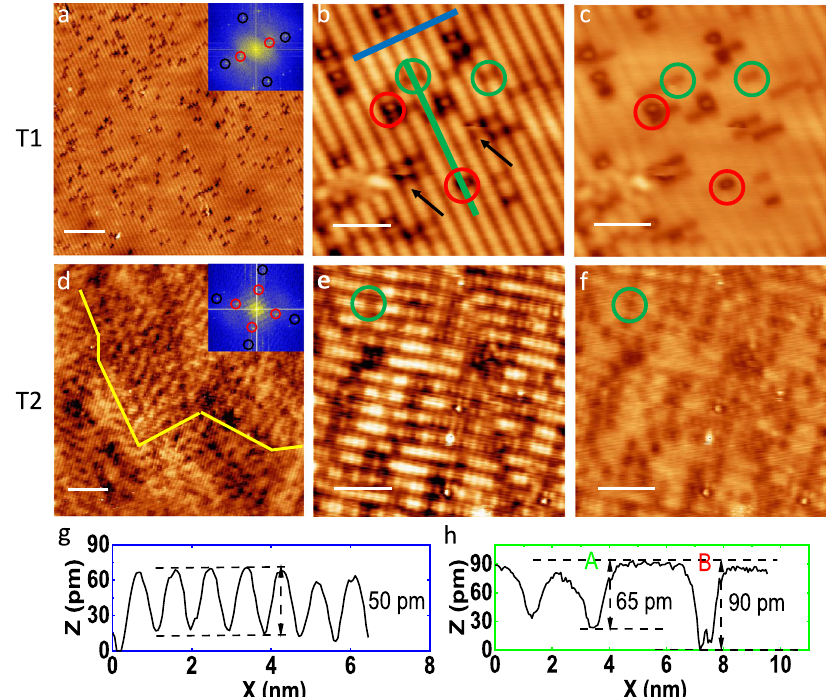
Fig. 2 Surface morphology of BaMnSb 2 showing two terminations: T1 (a – c) and T2 (d-f). a , d Large area STM images of T1 and T2. 2D-FFTs are shown in the insets with integer spots indicated by black circles, 2 × 1 spots in red circles. The scale bars represent 10 nm. b , e Atomically resolved images from T1 and T2. Two types of defects are circled in red and green circles. Black arrows in ( b ) point to moving defects generated by tip disturbance. Line pro fi les along the blue and green lines are shown in ( g and h ), A and B in ( h ) mark the positions of the two types of defects along the green line, respectively. A yellow line in ( d ) shows the reconstruction domain boundary. The scale bars represent 3 nm. c , f Defect maps of T1 and T2 created by removing 2 × 1 reconstructions. The scale bars represent 3 nm. Scan conditions: ( a ), − 1 V, 100 pA, ( b ), − 1 V, 100 pA, ( d ), − 1.5 V, 30 pA, and ( e ), − 0.6 V, 100